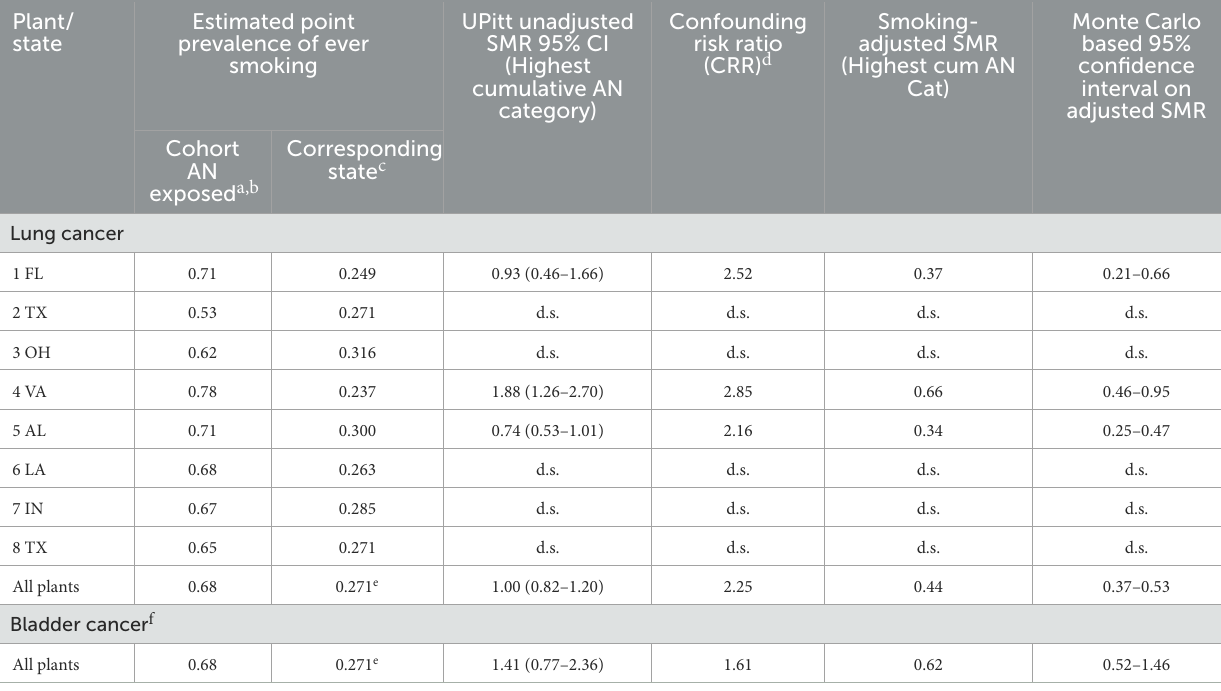
TABLE 8 Confounding risk ratios (CRR) and smoking-adjusted SMRs for lung and bladder cancer based on estimated cohort smoking prevalence rates, showing unadjusted SMRS by plant and overall, full cohort, 1942–2011. Plant/ Estimated point state prevalence of